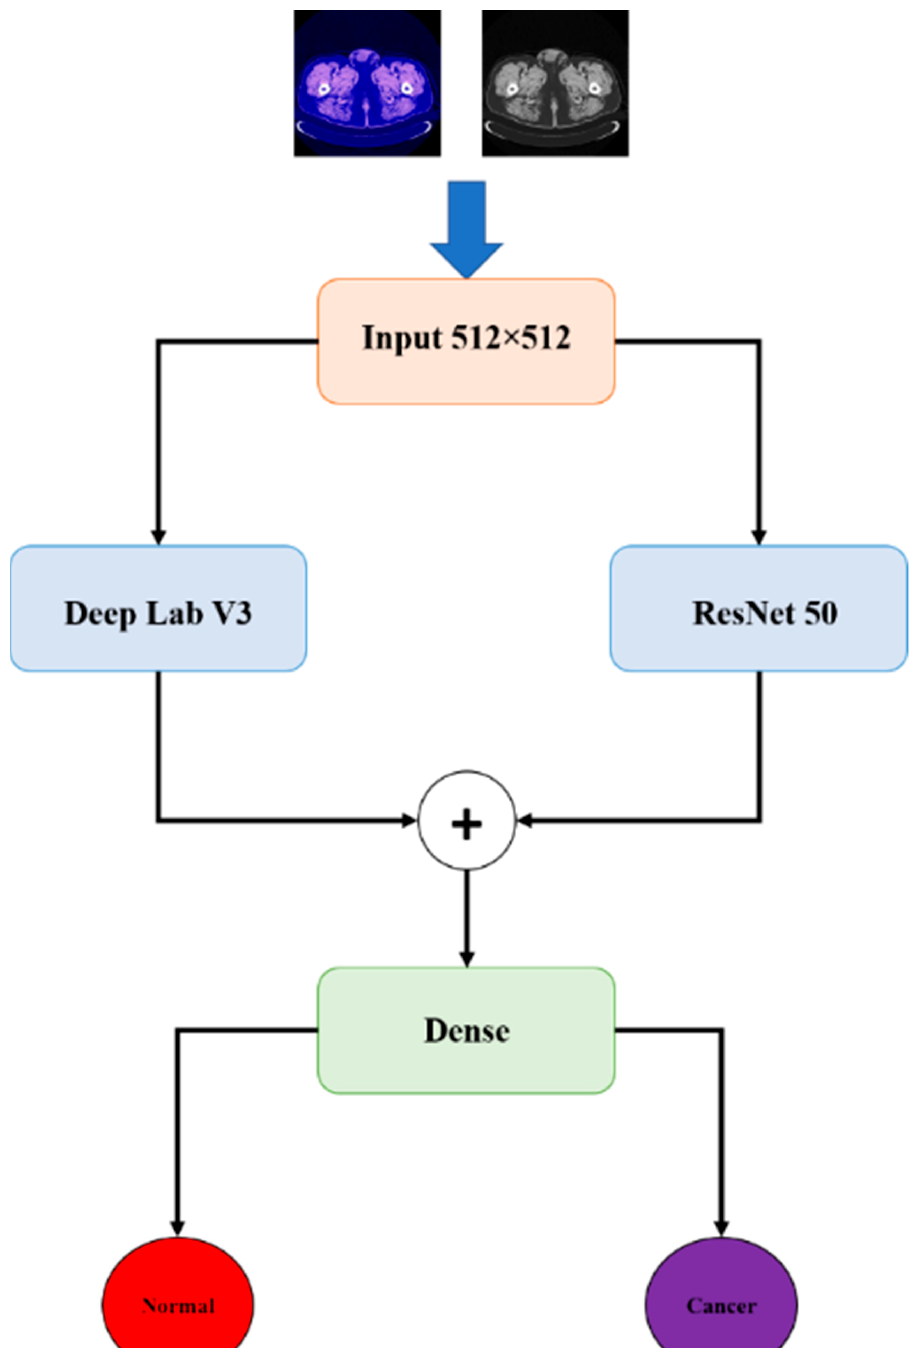
Figure 1. The components of the proposed model.